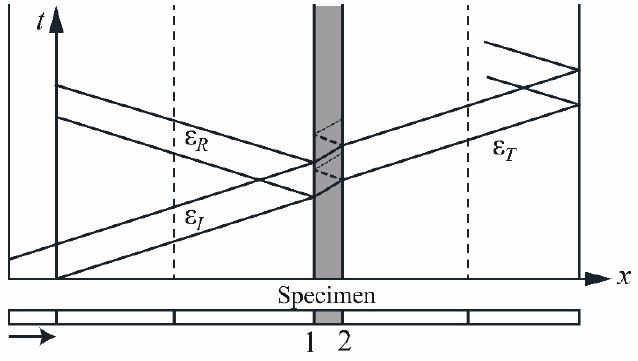
Figure 6. Wave propagation diagram (redrawn from Ramesh [ Error! Reference source not found. ]).